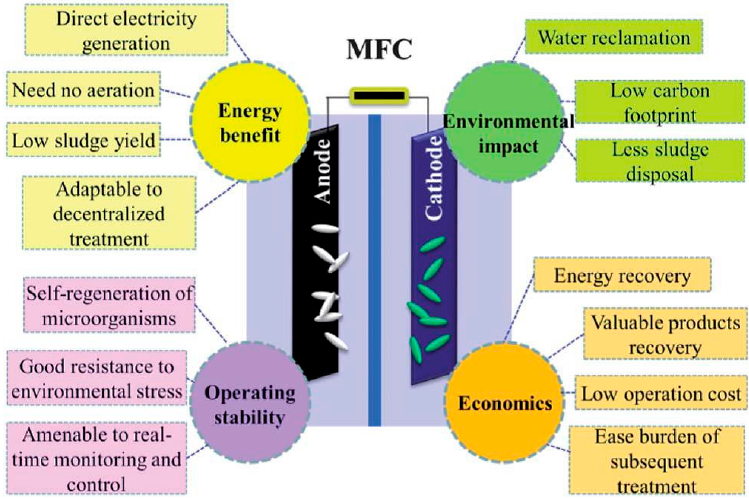
Figure 5. Potential benefits of MFCs for energy, environmental, operational and economic sustainability. Adapted from [81], with permission from © 2014 The Royal Society of Chemistry.